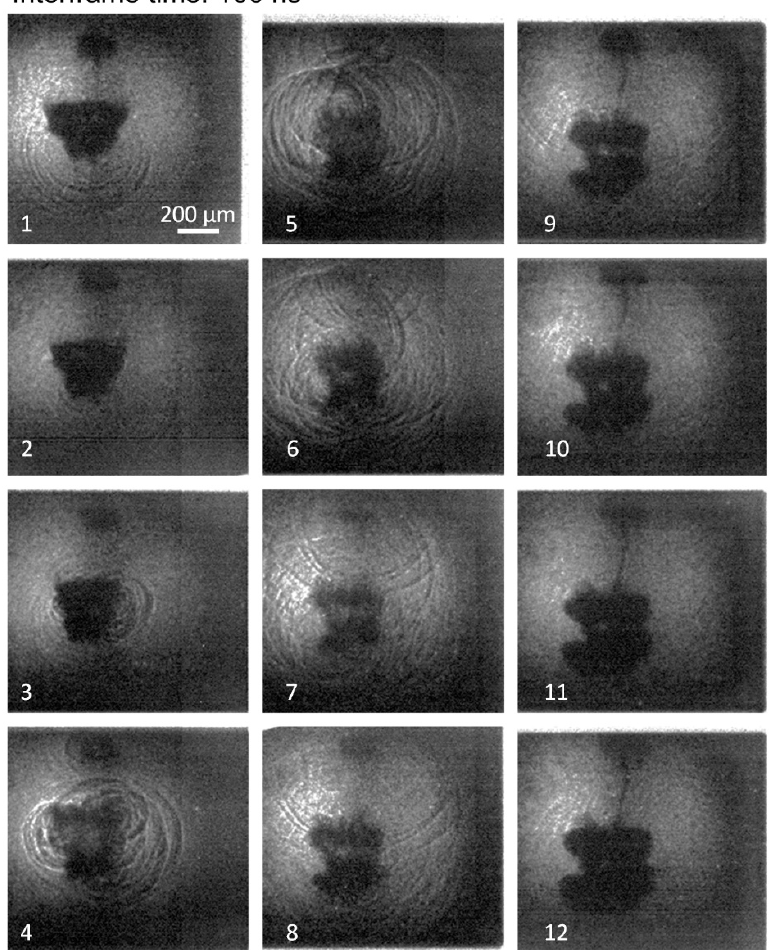
Figure 6. High-speed video imaging of a toroidal bubble. The series of photos are numbered 1 to 12 over time. A first shock wave is visible at the bottom of the bubble in photo 1. Shock waves are then formed at the top of the bubble in photo 3. This collapse type is classified to the elongated bubbles. Camera settings are: 10 million frames/s, and 5 ns exposure time. The scale bar is 200 µ